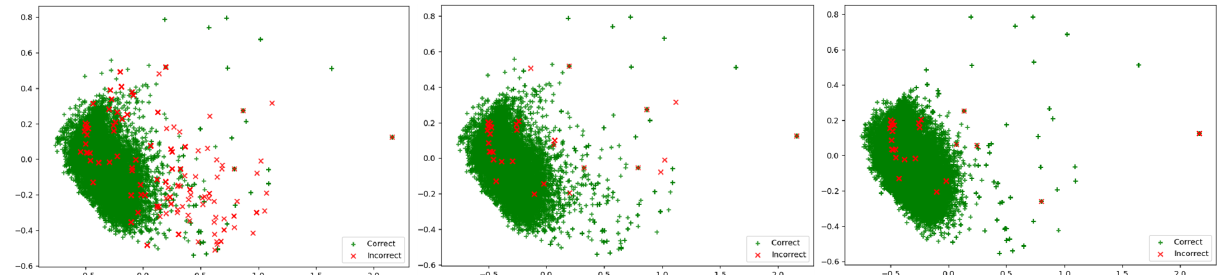
Figure 5. Class prediction. ( a ) Untrained model: class predictions of validation samples (accuracy: 71.80%), ( b ) trained model: class predictions of validation samples (accuracy: 90.47%), ( c ) trained model: class predictions of rest (accuracy: